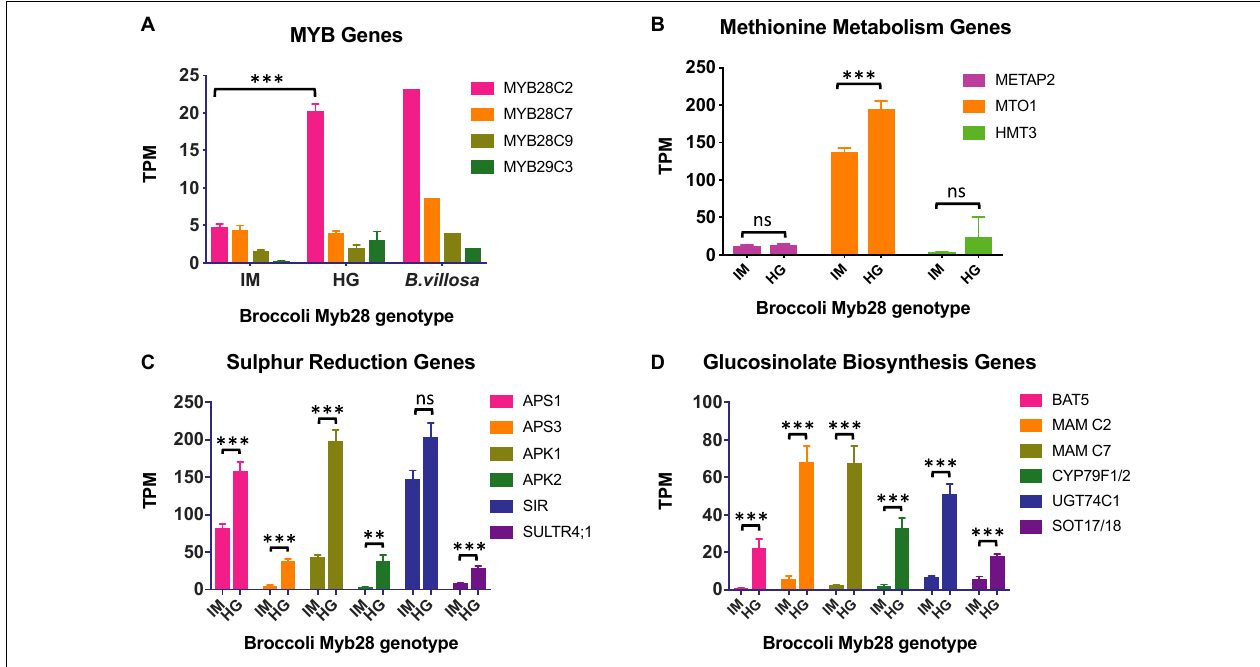
FIGURE 3 | (A) Relative expression (mean and se) of genes from RNAseq analyses in leaves from field-grown Ironman (IM) and high-glucoraphanin (HG) Inbred (HG). (A) MYB transcription factors. There is a significantly greater expression of MYB28 C2 in HG Inbred than IM ( p < 0.001). Other MYB28 C7, MYB 28 C9, and MYB29 C3 genes do not differ significantly in expression between HG and IM ( p > 0.05). For information, gene expression of MYB28 genes is also included from a single leaf of glasshouse grown Brassica villosa . (B) Sulphate reduction. There was significantly greater expression of sulphate reduction genes in HG Inbred compared to IM ( ∗∗∗ p < 0.01; ∗∗ p < 0.05) with the exception of SIR ( p > 0.05). (C) Methionine metabolism. Expression of MTO1 was greater in HG Inbred compared to IM ( ∗∗∗ p < 0.01). METAP2 and HMT3 did not differ significantly between HG Inbred and Ironman. (D) Glucosinolate biosynthesis. There was significantly greater expression of all glucosinolate biosynthesis genes in HG Inbred compared to IM ( ∗∗∗ p < 0.01). TABLE 2 | Gene Ontology (GO) terms associated with sulphur metabolism based on enriched genes differentially expressed ( p < 0.05) between HG MYB28 V/V broccoli compared to 9 standard broccoli MYB28 B/B.